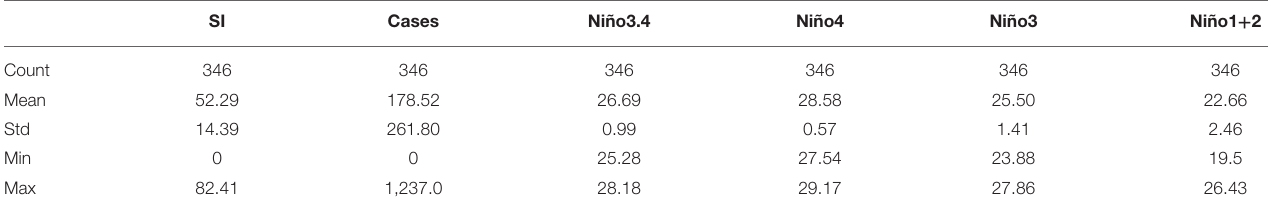
TABLE 1A | Descriptive statistics of the data used (January 21, 2020 to December 31, 2020). SI Cases